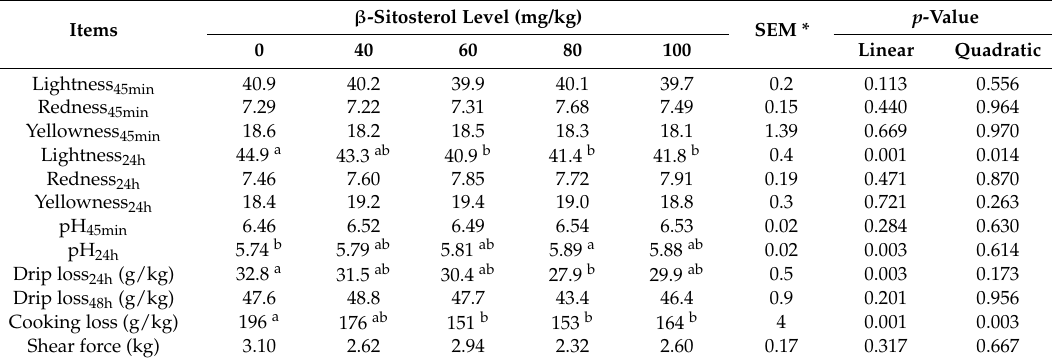
Table 4. Effect of dietary β -sitosterol supplementation at different levels on meat quality of breast muscle in broilers.